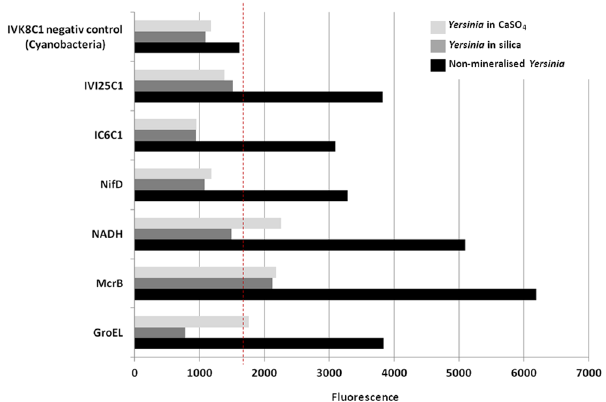
Figure 4. Bar diagram showing the fluorescence emission of general antibodies directed to the universal, either with non-mineralized Yersinia (black bars), with Yersinia 6 months in silica (dark grey bars) or 6 months in gypsum (light grey bars).